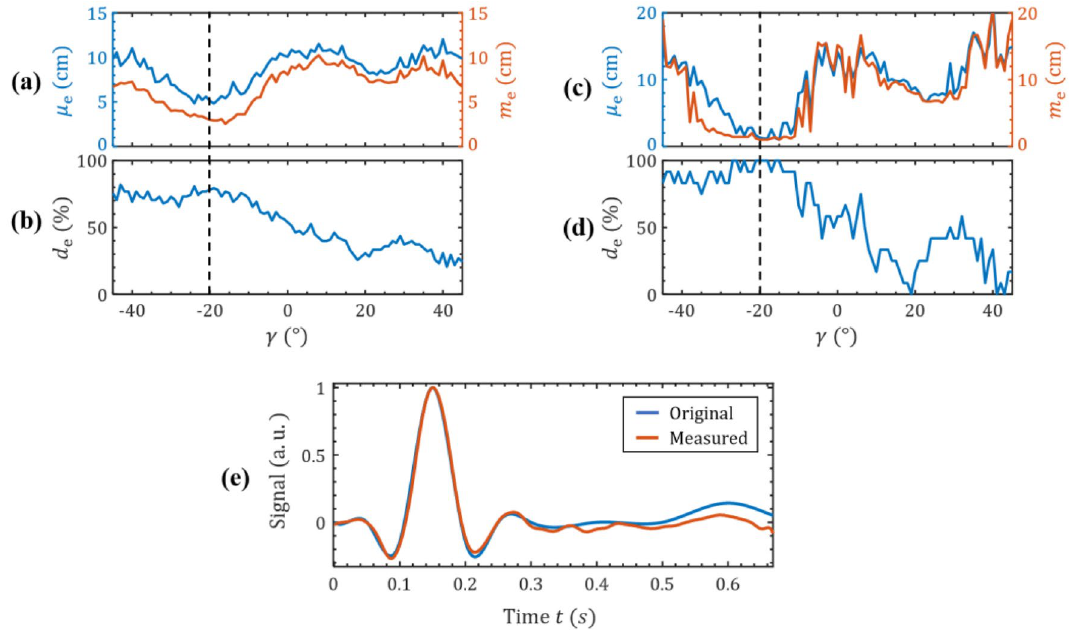
Figure 6. Localization and dual-mode measurement. Average localization error as a function of the tilt γ of the sensor’s sensitivity axis for the localization for all of the tested position-orientation-pairs shown in Fig. 5b. In ( a ) the mean µ e and median m e Euclidean distance between real and estimated sensor positions and in ( b ) the percentage of correct estimated sensor orientations are shown. ( c ) Average localization error as a function of γ for the localization of the blue set of positions in Fig. 5b, ( c ) The mean µ e and median m e Euclidean distance between real and estimated sensor positions and in ( d ) the percentage of correct estimated sensor orientations is shown. ( e ) Demodulated, detrended, lowpass-filtered and normalized magnetic test signal measured by the ME sensor in the 2 nd bending mode and original normalized transmitted signal. Due to the larger bandwidth of the sensor in resonance mode RM2 the signal can be reconstructed